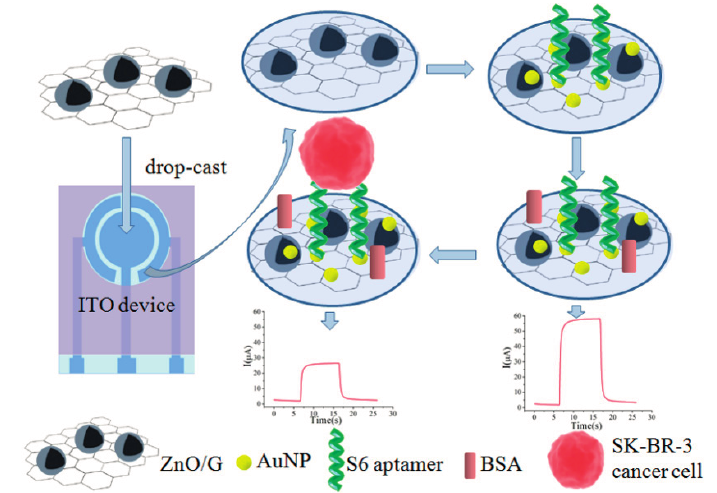
Figure 6. Schematic of the fabrication of an Apt-AuNP dotted ZnO/G modified indium tin oxide device. As shown, the ZnO/G composite was deposited onto the indium tin oxide micro device. Next, AuNPs were electrodeposited for the immobilization of aptamers specific for SK-BR-3 cancer cells. After the target cells are captured, photoelectrochemical measurements were carried out based on the addition of ascorbic acid. The image was adopted from